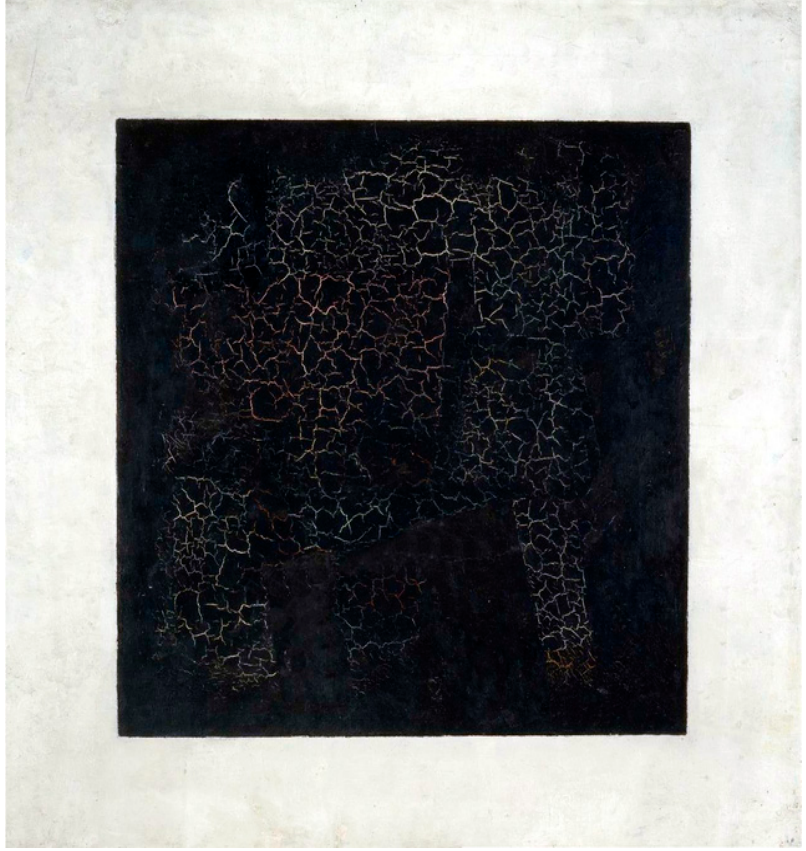
Figure 17. Kazimir Malevich. Black Square. The painted structure of Malevich’s coloring resembles to some extent the known traditional technique of the Orthodox Icon painting.